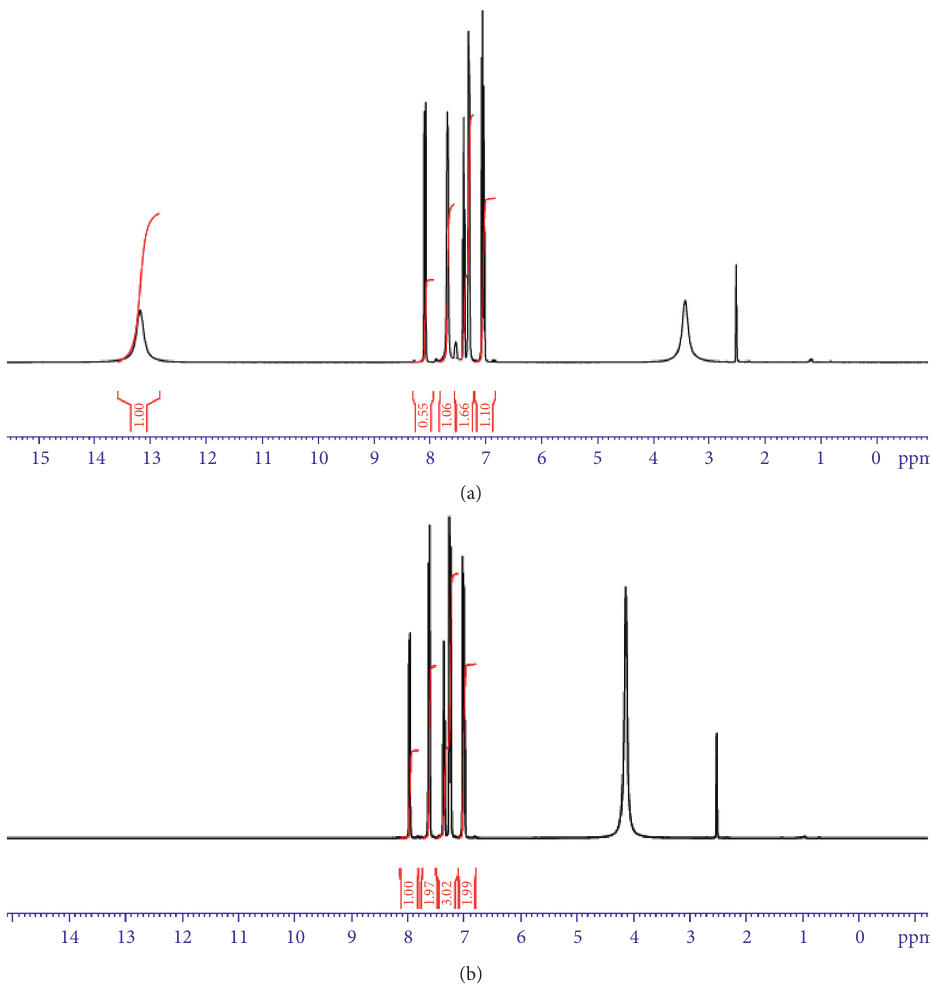
Figure 4: 1 H-NMR spectra of H